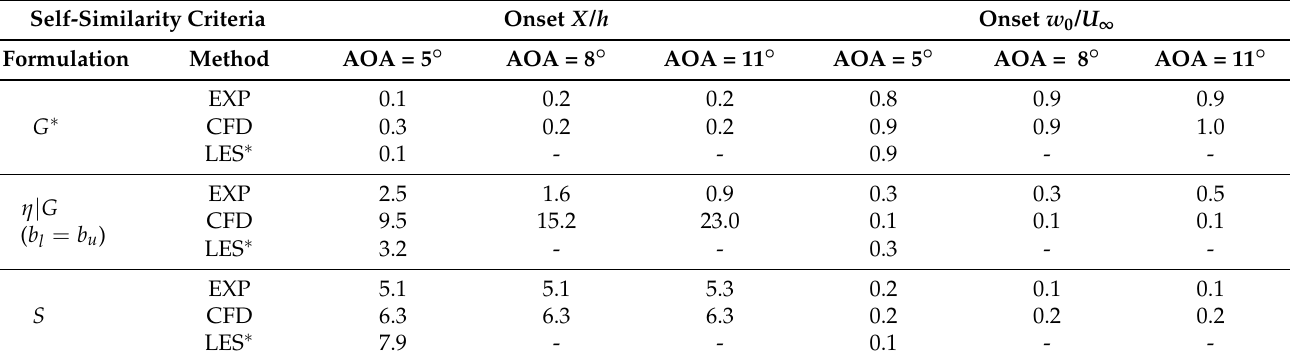
Table 5. Similarity onset according to different